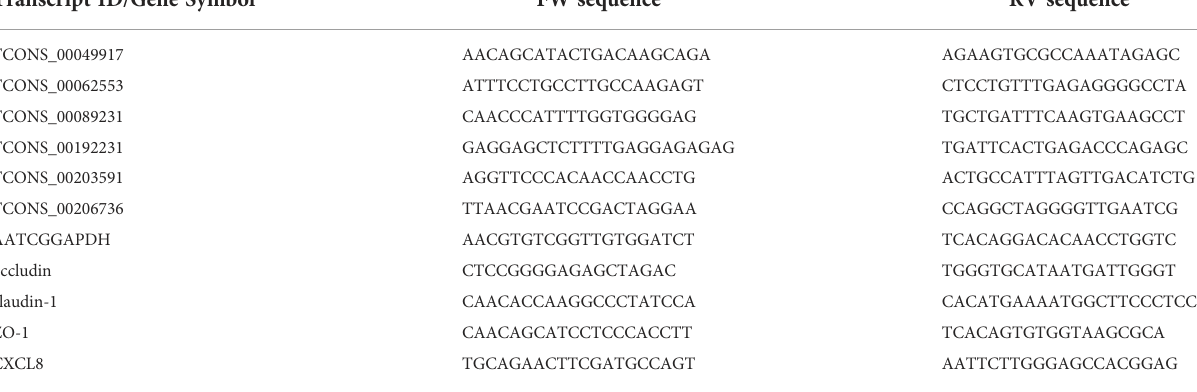
TABLE 4 Primer sequences used in